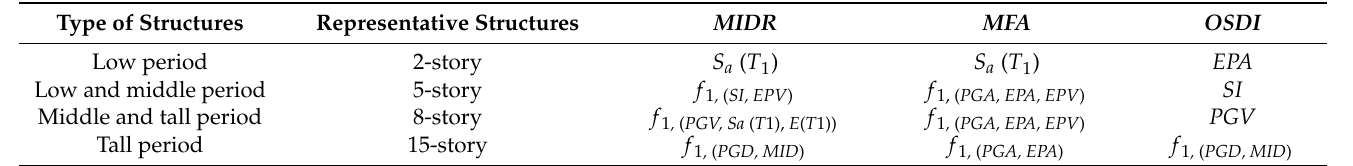
Table 11. Ranking of pulse-like ground motions based on optimal IMs under different